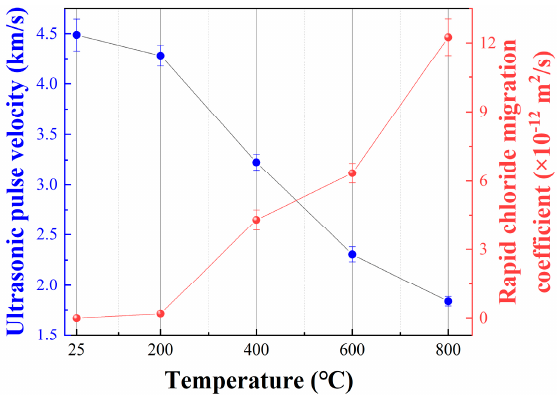
Figure 8. Results of RCM after exposure to high